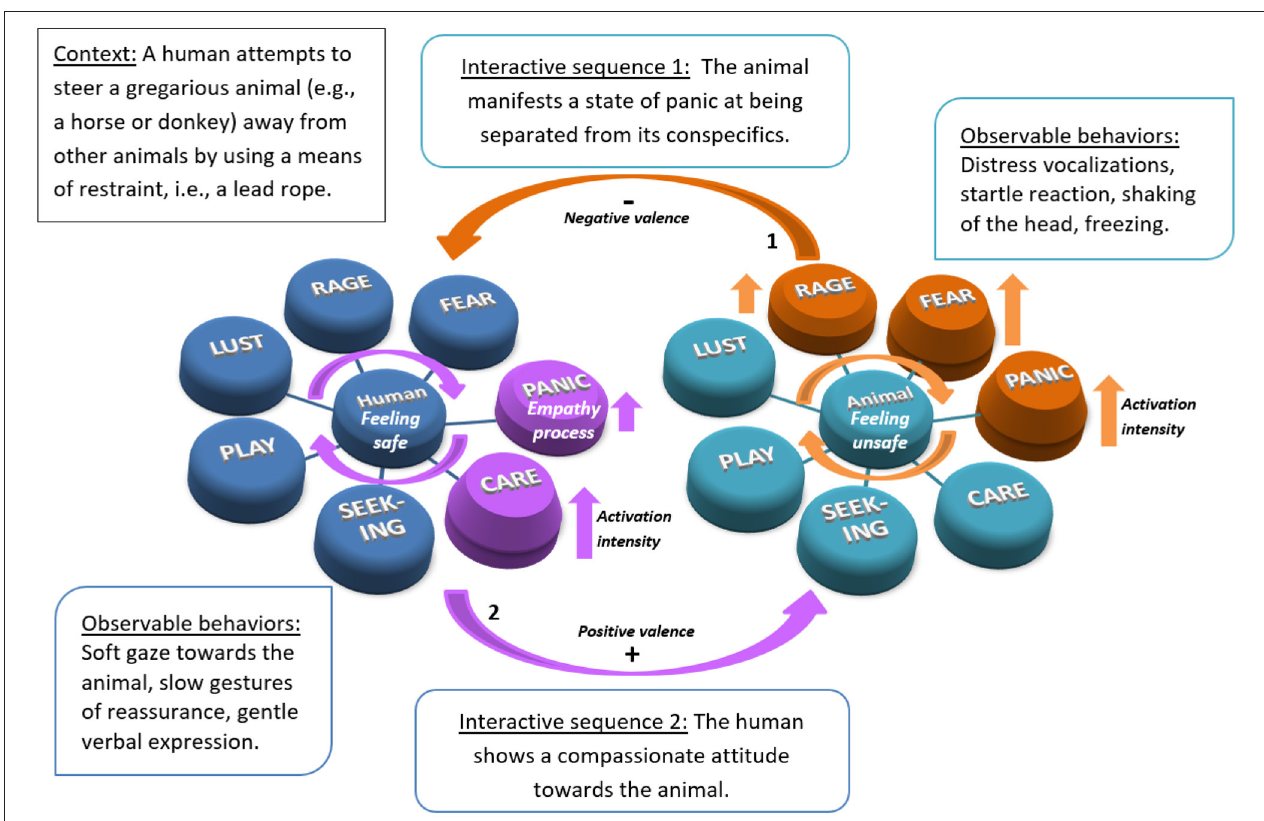
FIGURE 3 | Example of hypothetical IMHAI modeling of the interspecies interactive emotional regulation process.